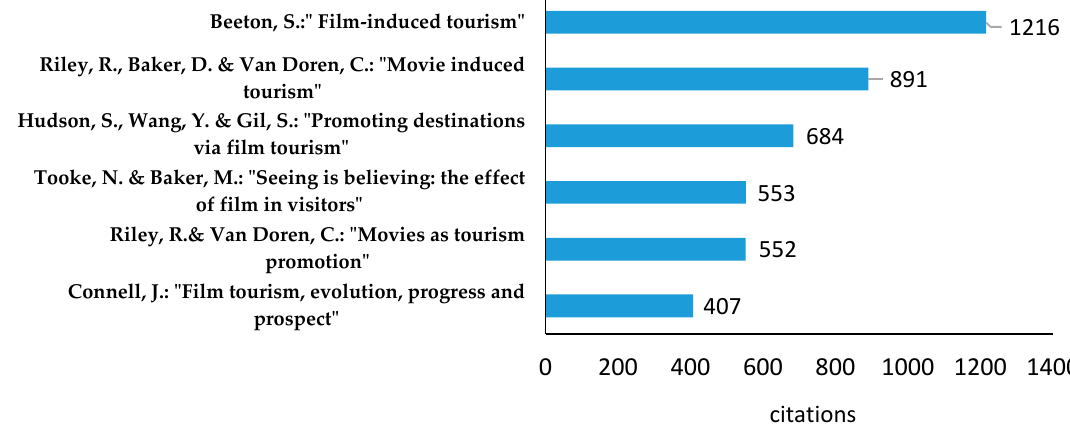
Figure 2. Most cited publications on film tourism in 2020. Source: own elaboration.